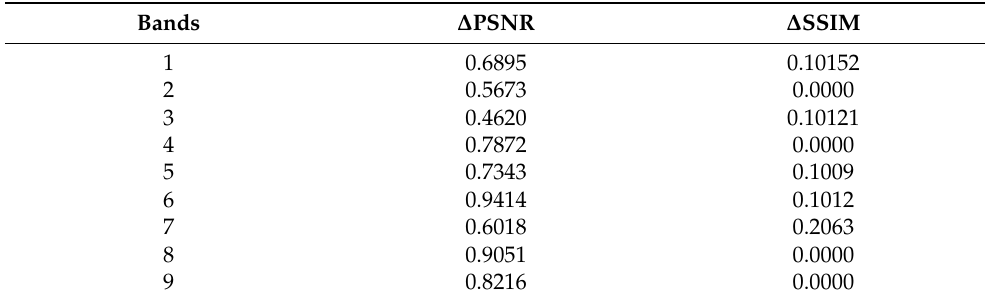
Table 3. Percentage variation comparison over Lombardia Sentinel-2 dataset between PReLU and ReLU activation functions (gain percentage respect to